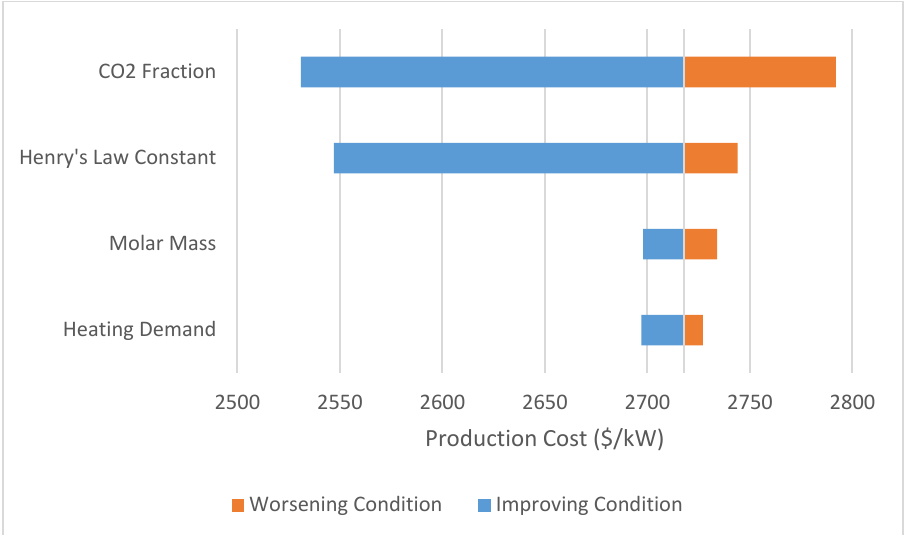
Figure 5. Sensitivity of analysis to changing solvent parameters; the amount of CO2 present and the Henry’s law constant are the most significant factors affecting price — both of which contribute to operation pressure.